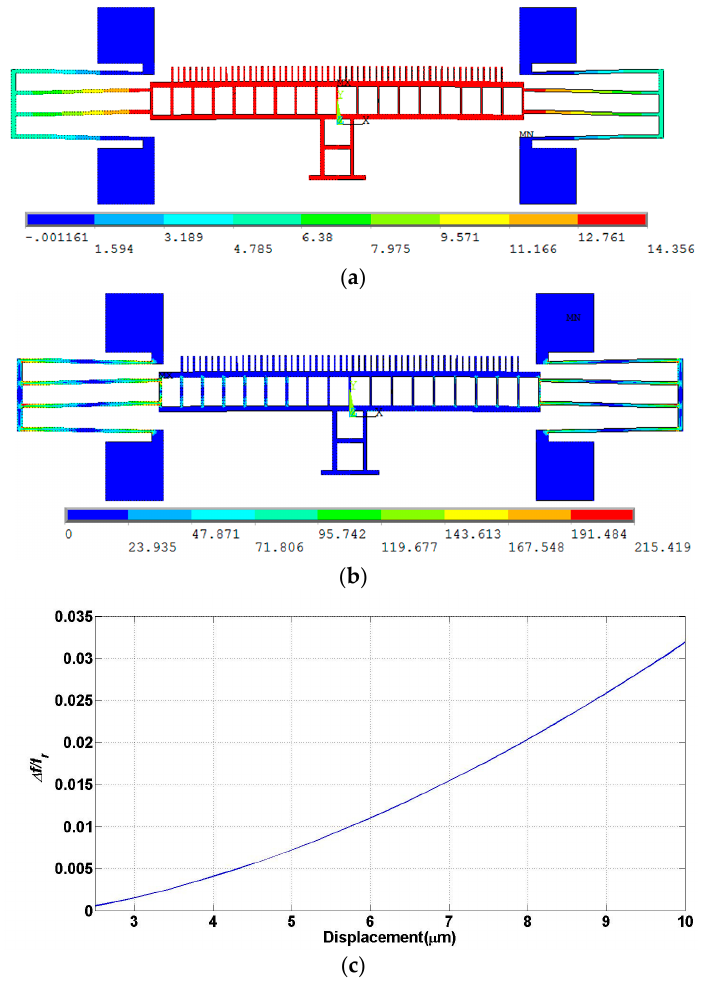
Figure 2. Finite element analysis (FEA) of design A: ( a ) Actuator displacement in μ m; ( b ) Stress profile in μ N/ μ m 2 and ( c ) Resonant frequency shift percentage, percentage of difference in frequency divided by resonance frequency f r , versus displacement.